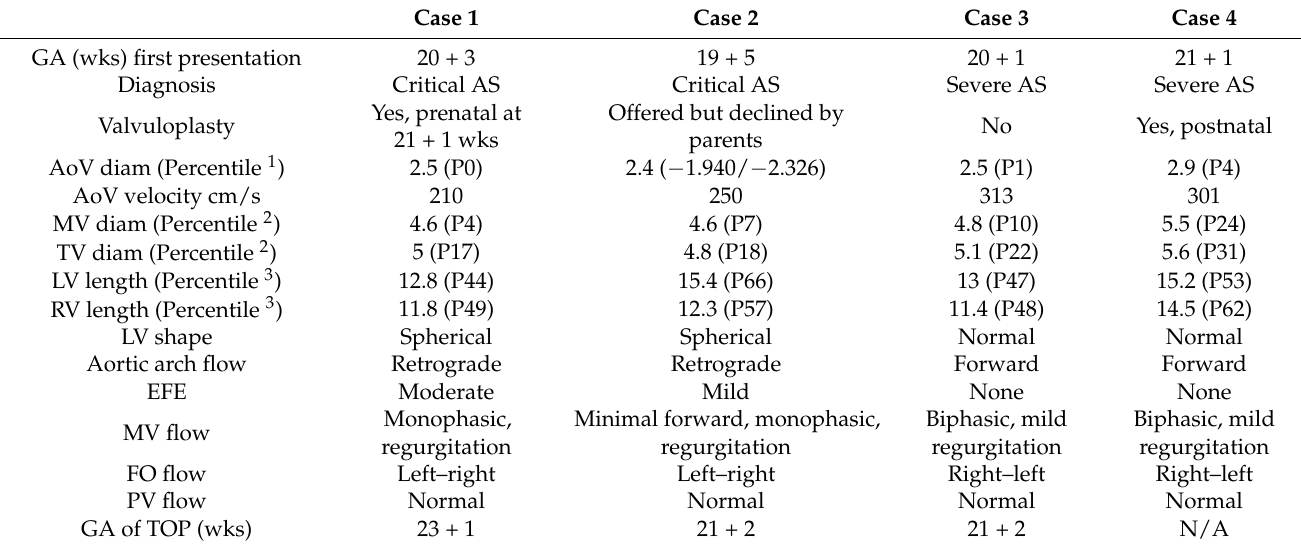
Table 2. Ultrasonographic baseline characteristics at first